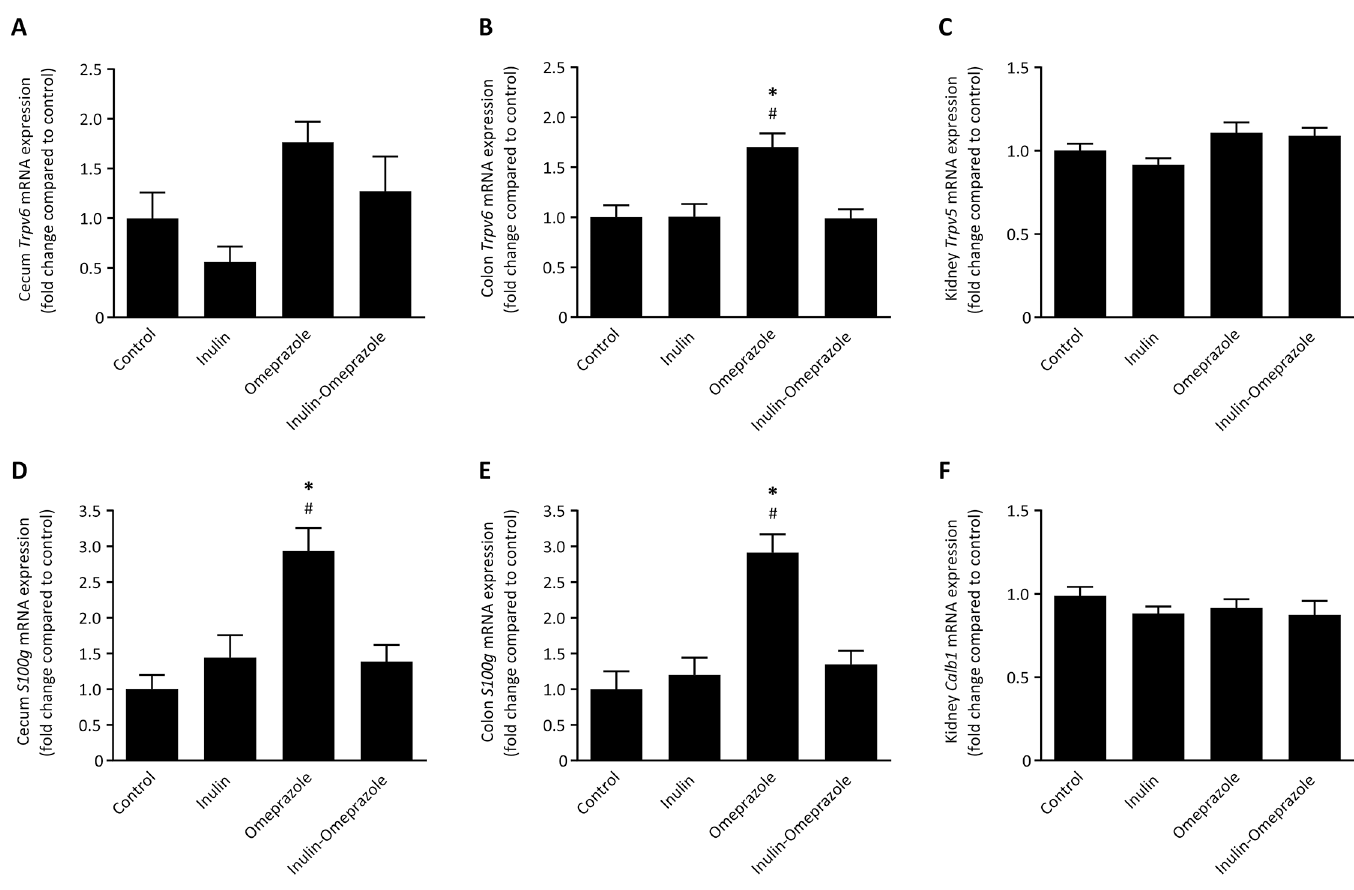
Fig 4. Effects of omeprazole and 10% inulin-enriched diets on mRNA expression levels of the calciotropic genes. Trpv6 and S100g mRNA in cecum (A + D), colon (B + E) and mRNA of Trpv5 and Calb1 in the kidney (C + F), corrected for Gapdh and normalized to control. Significant differences compared to control are indicated by * with P < 0.05, significant differences between the omeprazole-treated groups are annotated by # with P < 0.05. All values represent means ± SEM, with n = 10 mice per